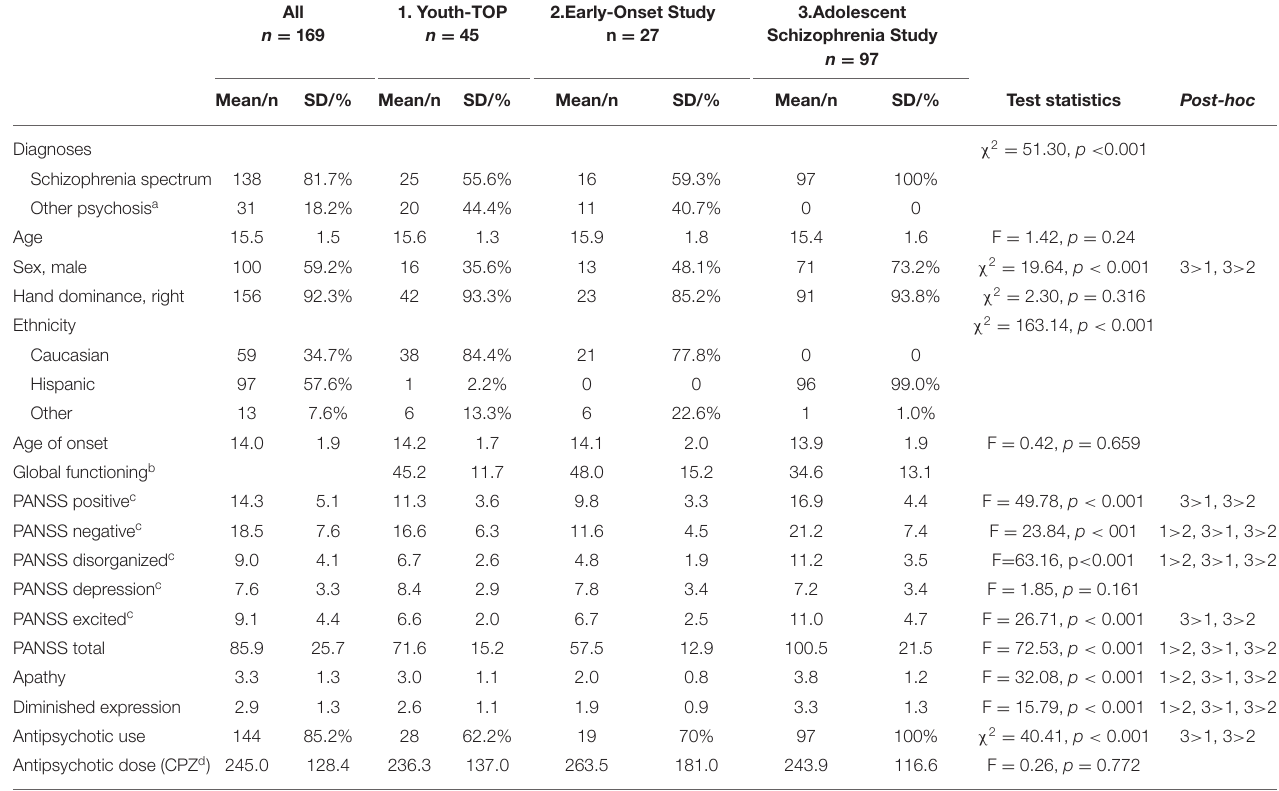
TABLE 1 | Demographic and clinical data.